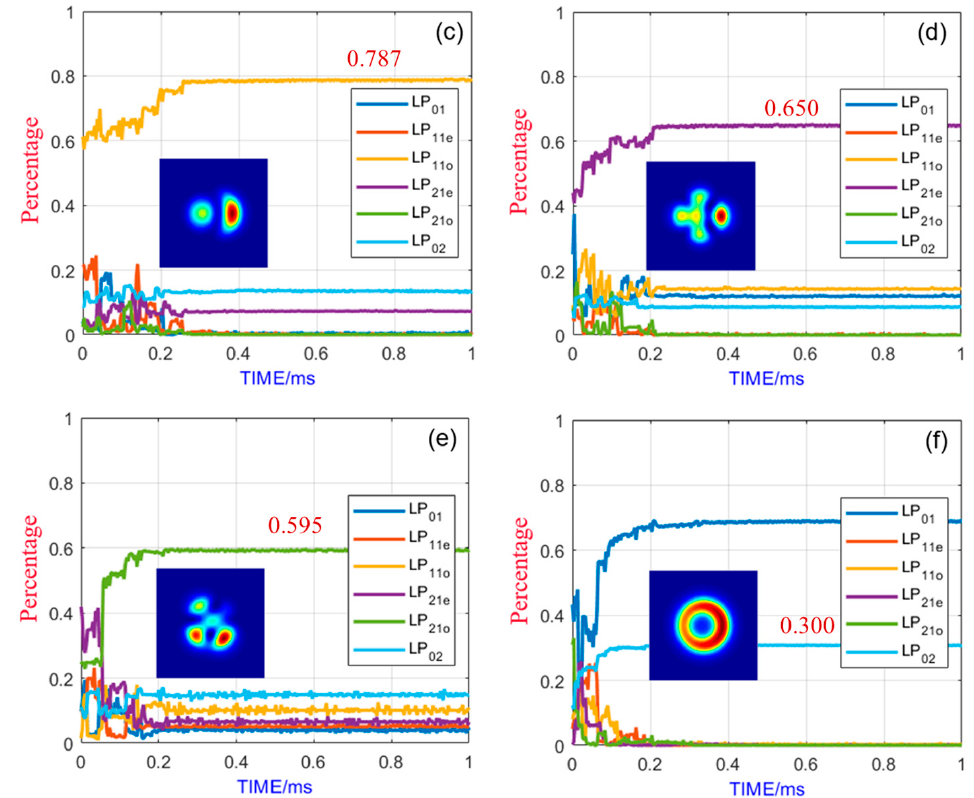
Figure 4. Mode content evolution of 6 × 1 photonic lantern initialized by the equal amplitudes, where the desired mode is chosen as the evaluation function. ( a ) LP 01 , ( b ) LP 11e , ( c ) LP 11o , ( d ) LP 21e , ( e ) LP 21o , and ( f ) LP 02 . The time window is set to 1 ms as the curves mostly stabilize.